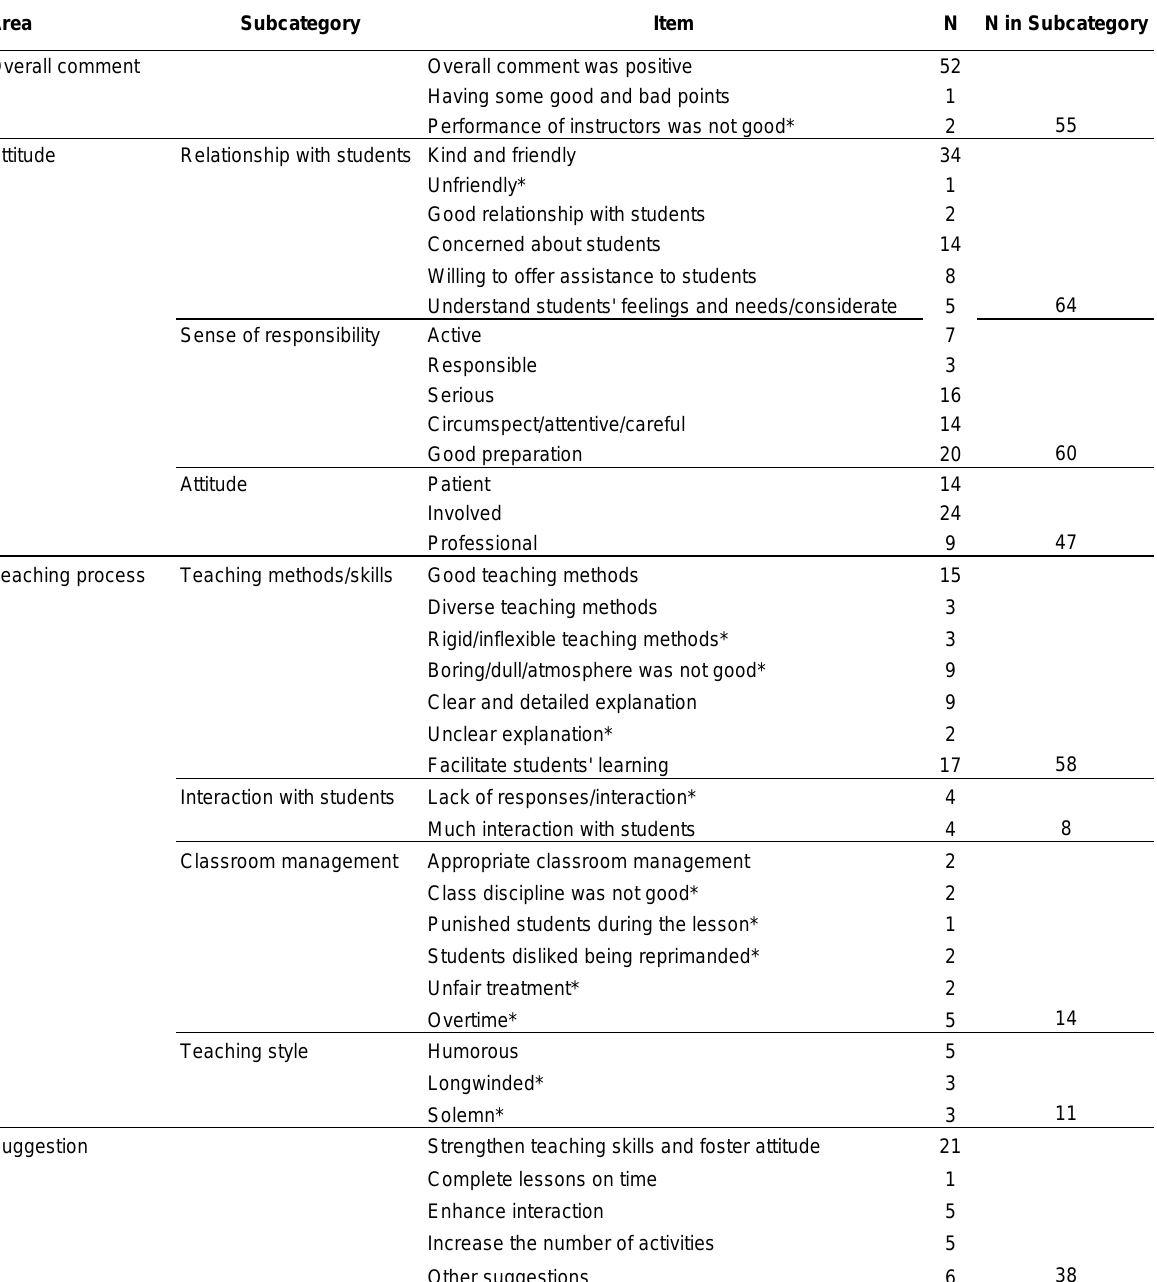
Summary of the Students' Responses to the Question “What Comments did the Students have